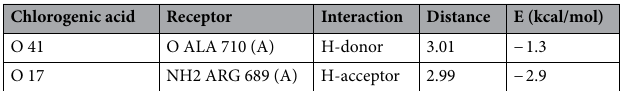
Table 5. Chlorogenic acid interaction with 6U7H